Question: Which kind of chart has been used to present this data?
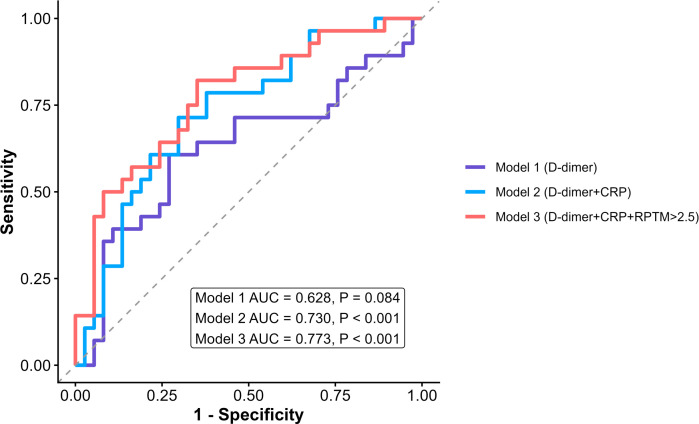
Answer: line